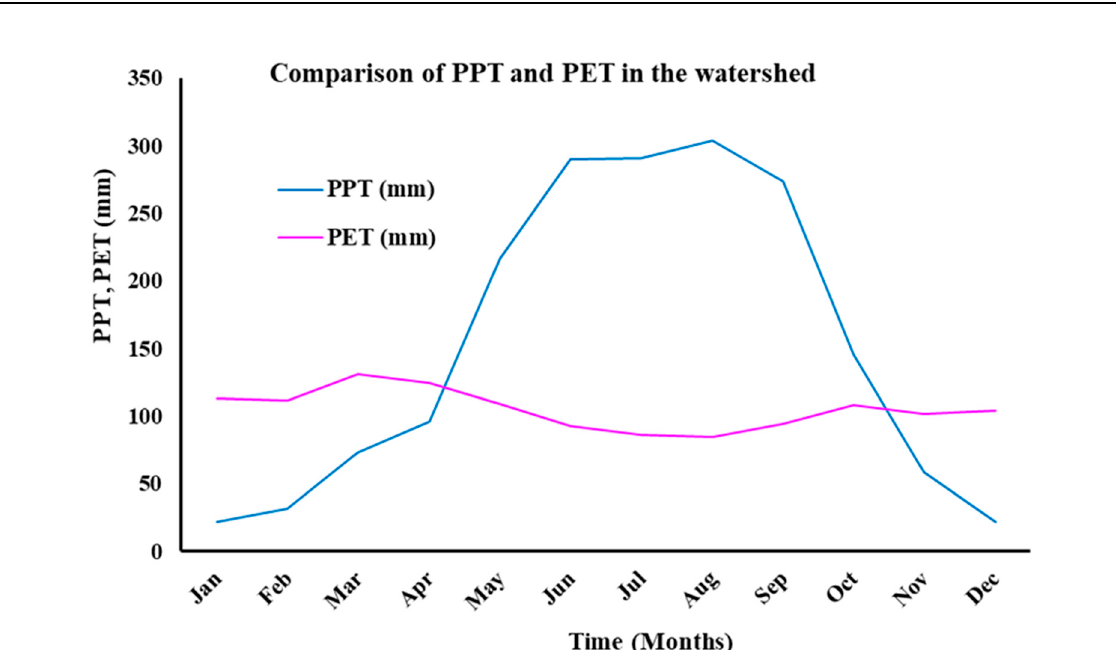
Figure 9. Long-term (1961–1990) precipitation and potential evapotranspiration (NMA and FAO LocClim database).